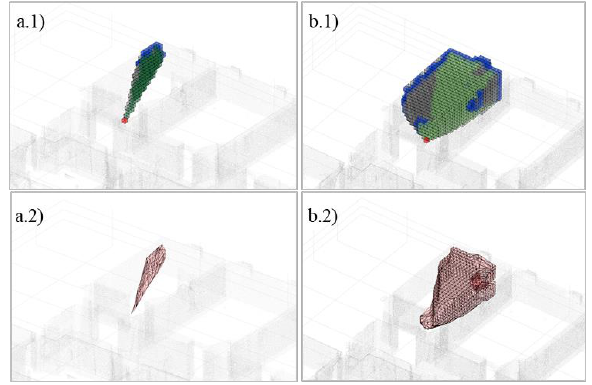
Figure 8. a) Ceiling and floor have been cut out for improving visibility of figures.